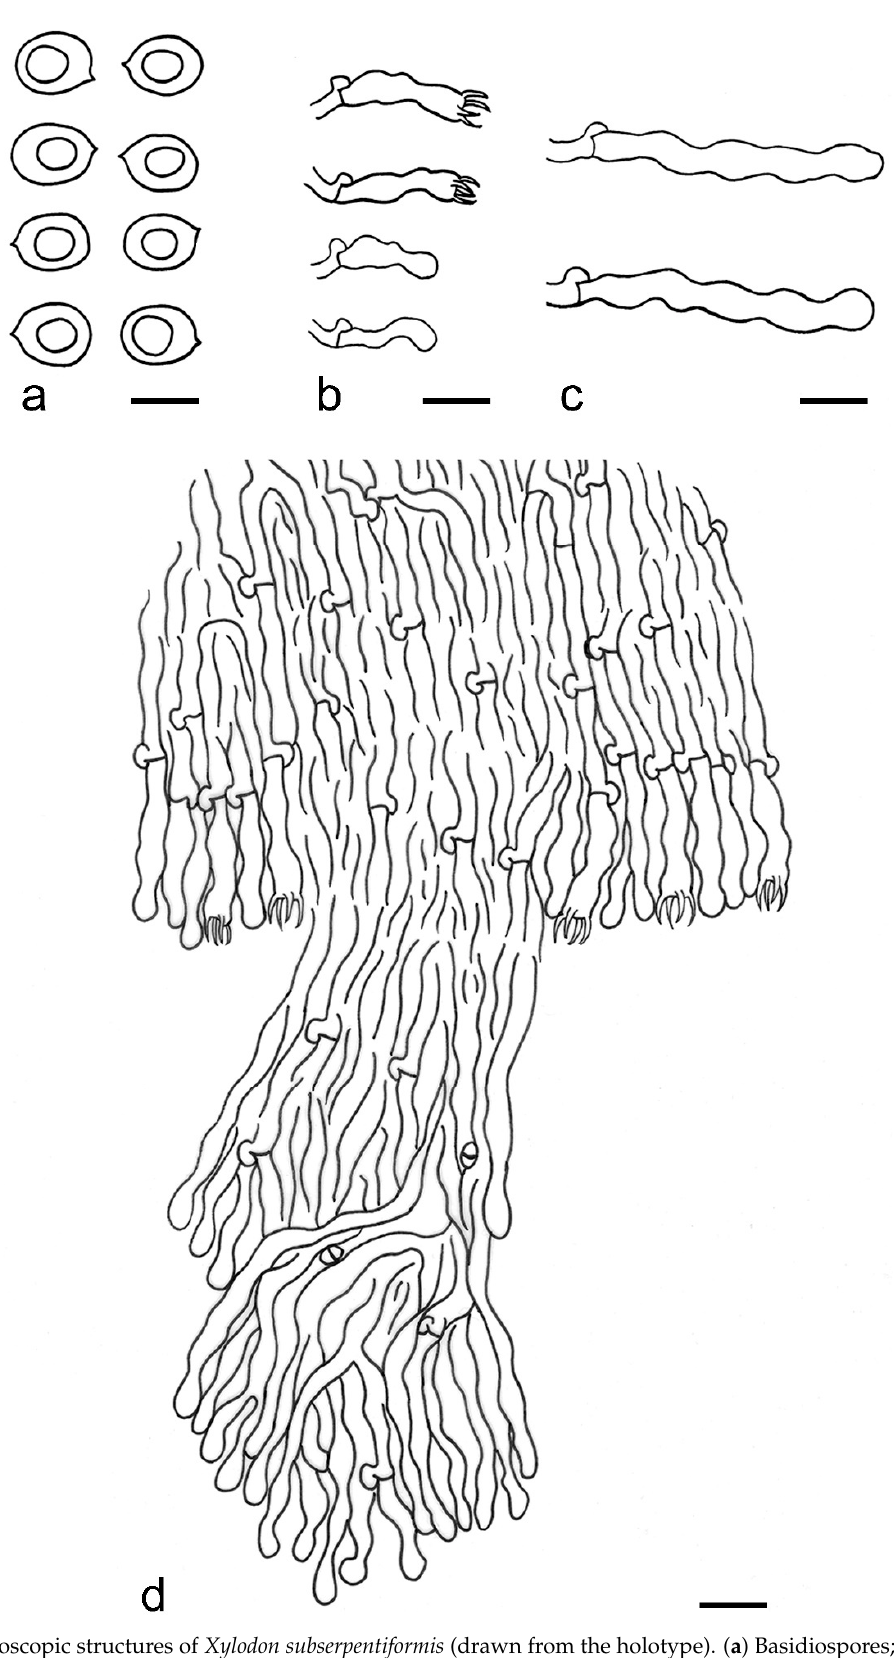
Figure 31. Microscopic structures of Xylodon subserpentiformis (drawn from the holotype). ( a ) Basidiospores; ( b ) basidia and basidioles; ( c ) tramacystidia; ( d ) a section of the basidiocarp.—Scale bars: a = 5 μ m; b–d = 10 μ m.